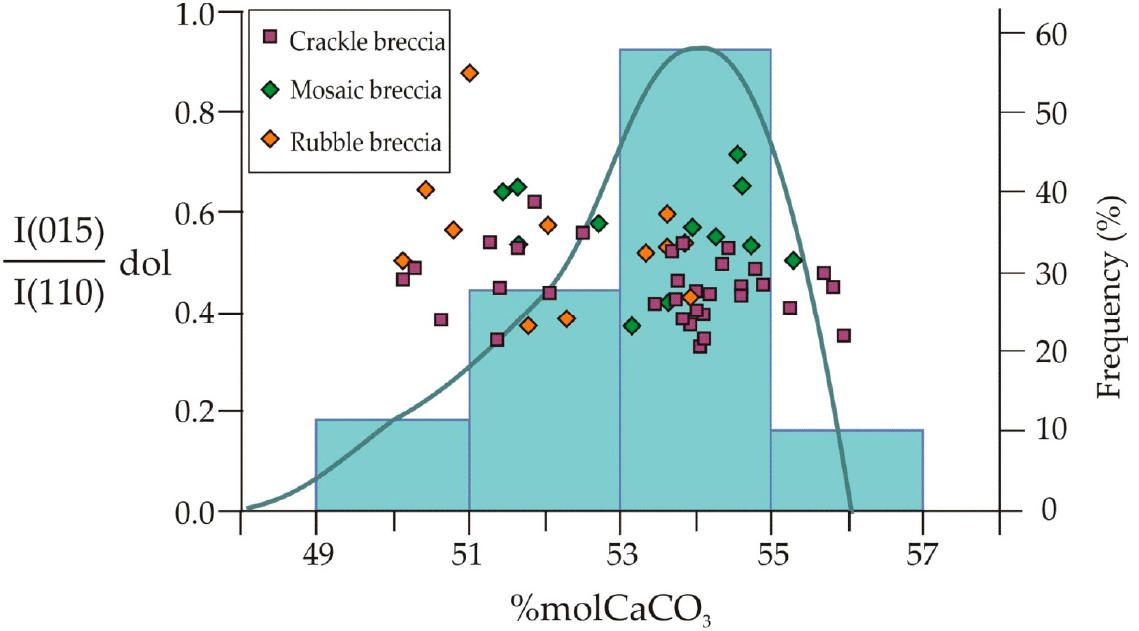
Figure 6. Degree of ordering of the analysed samples. Order ((I (015)/I (110)) vs. stoichiometry (% molCaCO 3 ).